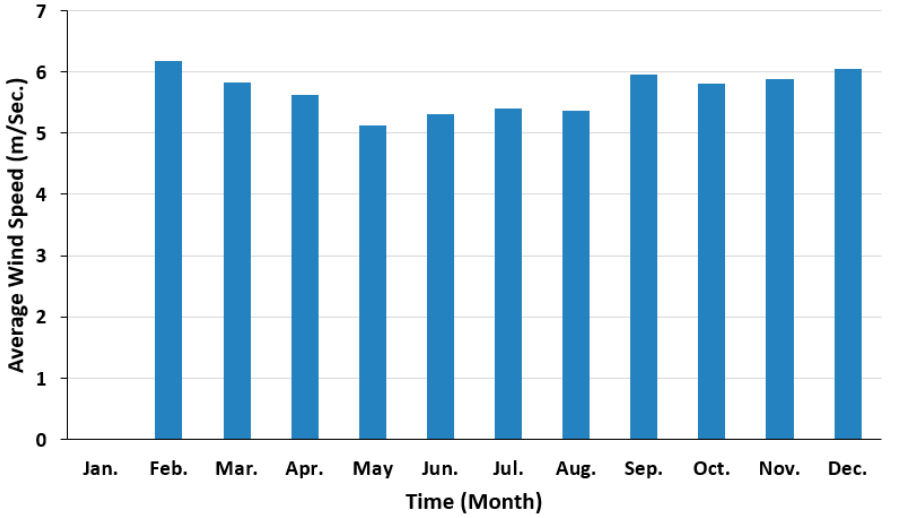
Figure 5. Monthly wind speed data.